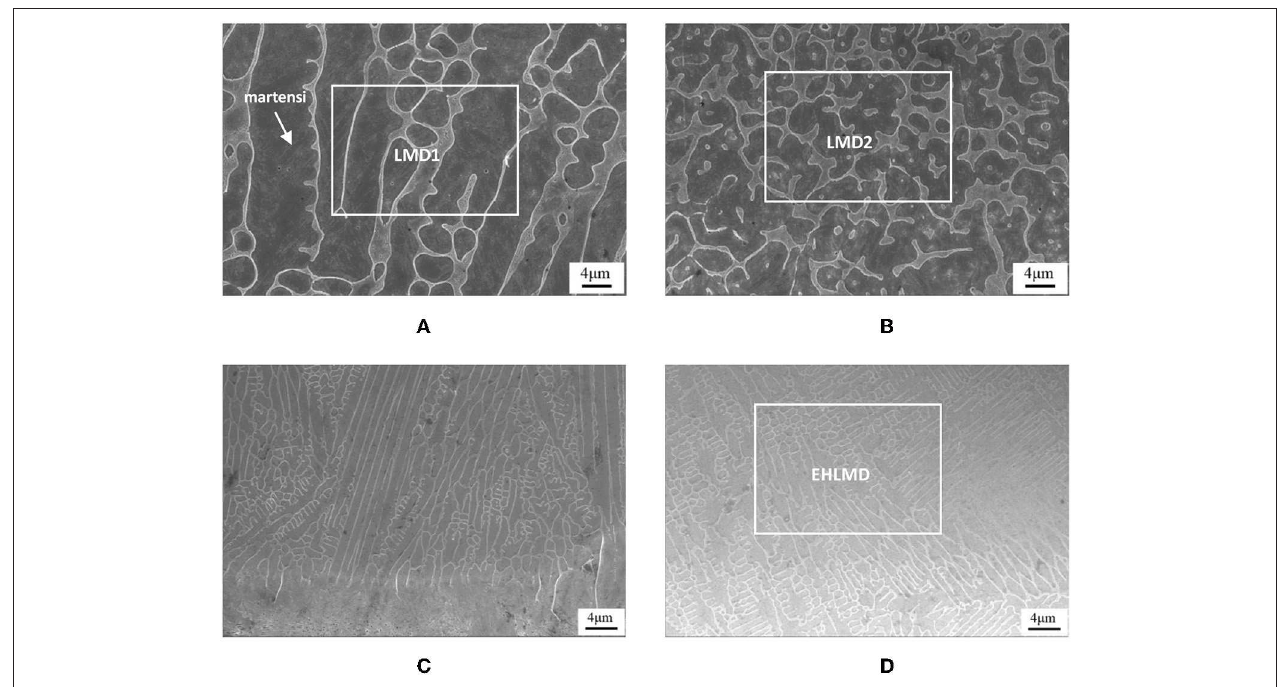
FIGURE 5 | SEM of LMD and EHLMD layer. (A) Bottom of LMD layer; (B) middle of LMD layer. (C) Bottom of EHLMD layer; (D) middle of EHLMD layer.